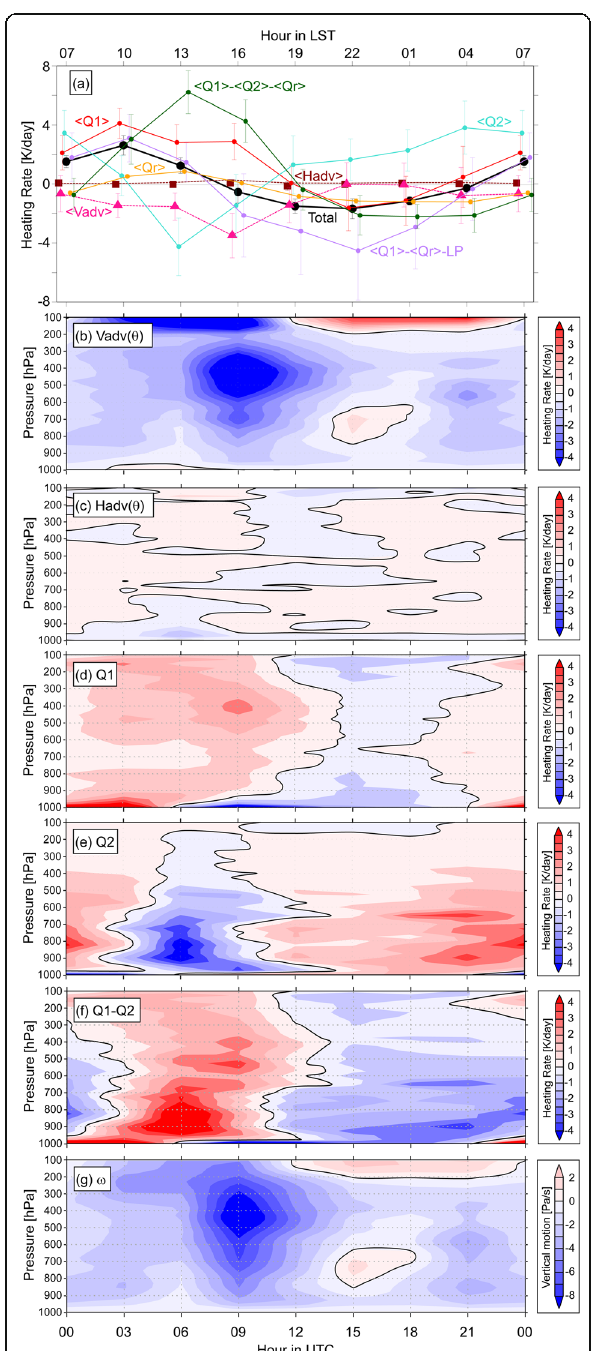
Fig. 10 Same as Fig. 9, but for the heat budget. a is for the vertically integrated values of each of the terms in the thermodynamic budget analyses. b to g are in the time – pressure cross section, for b array-scale vertical advection, c array-scale horizontal advection, d Q1 , e Q2 , f Q1 – Q2 , and g the array-scale vertical air motion in pressure coordinates (same as Fig.